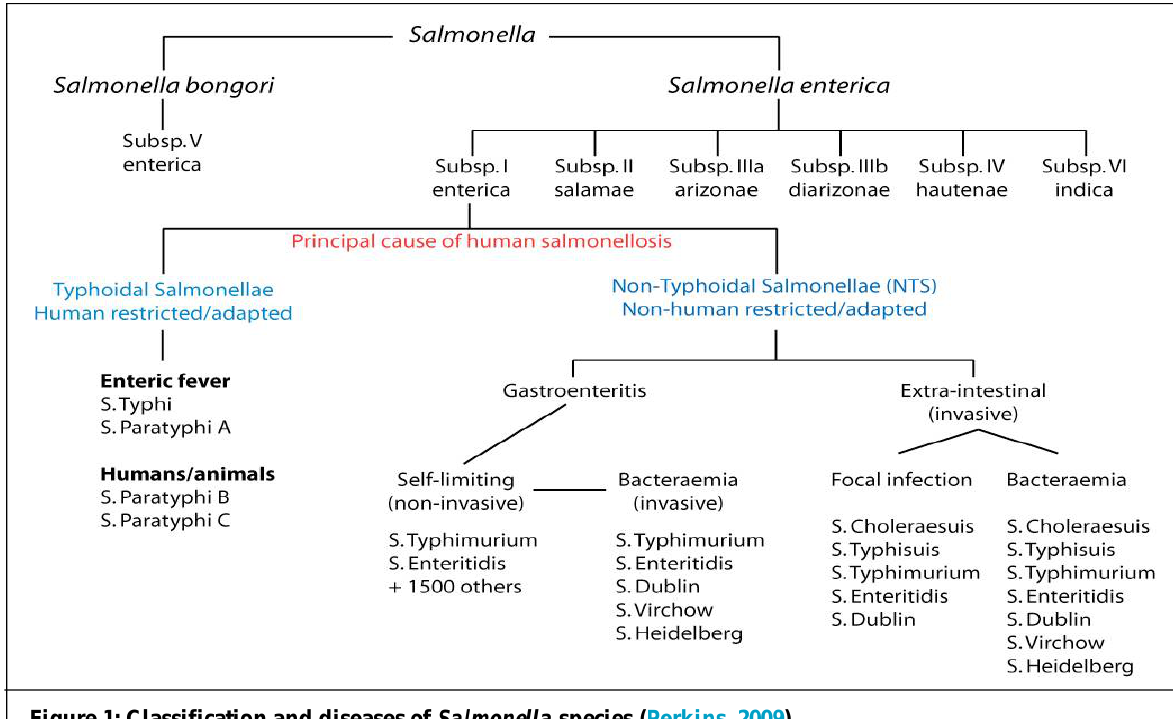
Figure 1: Classification and diseases of Salmonella species (Perkins, 2009) intestinal lymph nodes, liver and spleen where they multiply (Kaur and Jain, 2012). A significant percentage of normal animals harbor Salmonella in their intestinal tracts (Jajere et al .,